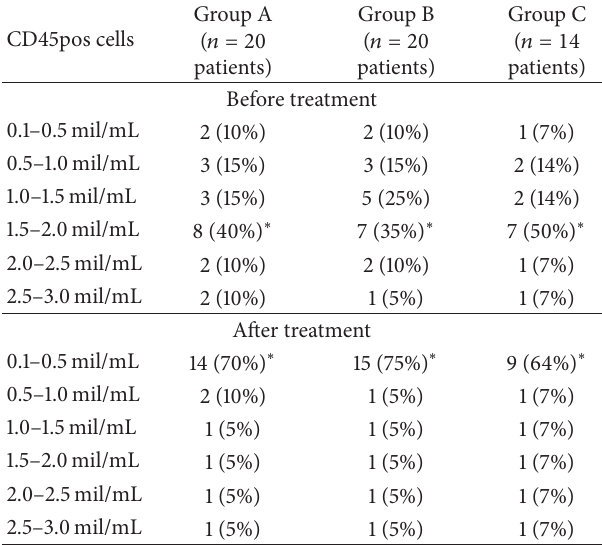
Table 4: The percentage distribution of patients according to the different concentrations of CD45pos cells before and after